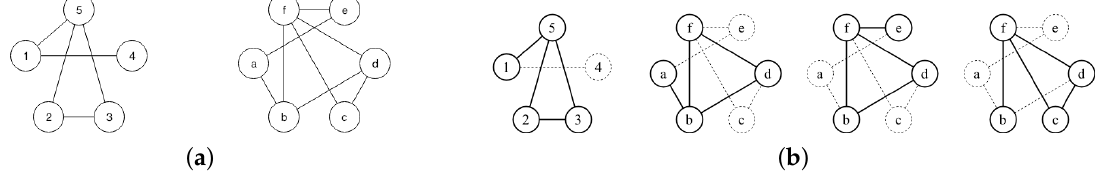
Figure 2. Given the graphs G and H represented in ( a ), ( b ) reports 4 different possible maximum common subgraphs (MCSs). Labels are shown only to help identify the